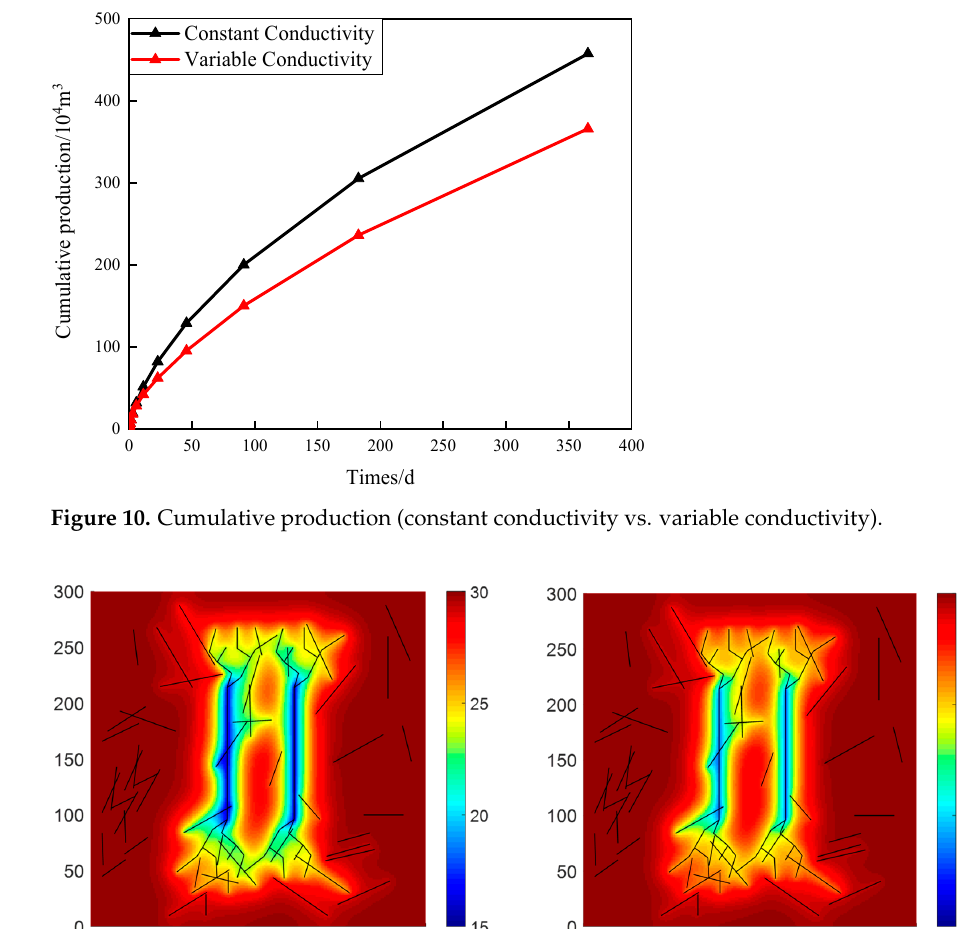
Figure 10. Cumulative production (constant conductivity vs. variable conductivity).